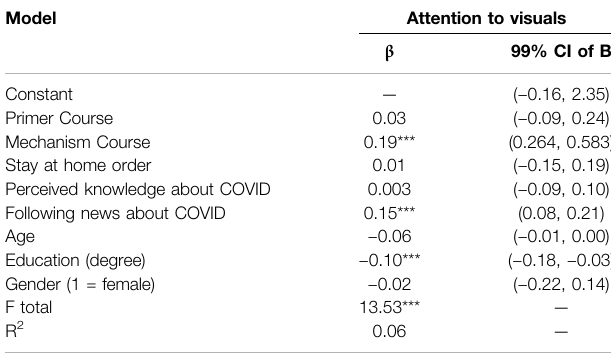
TABLE 2 | Results of linear regression analysis predicting attention to visuals. Model Attention to